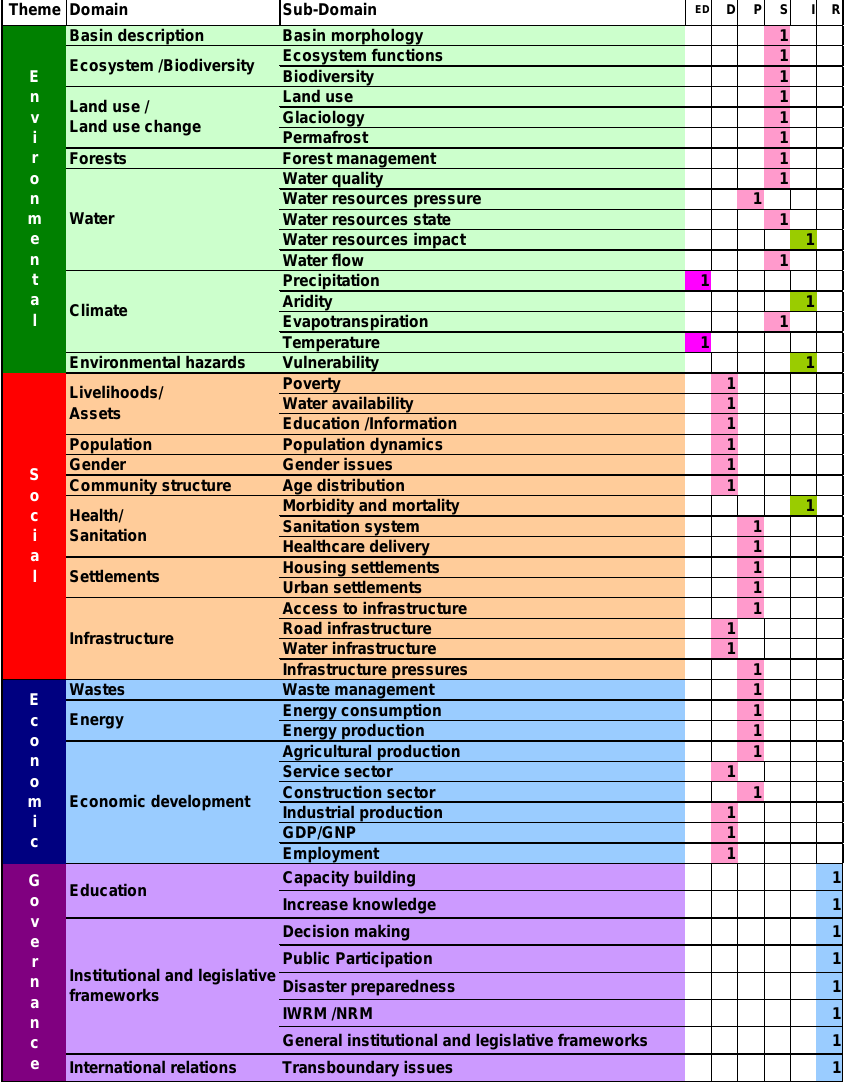
Table 6.1: Integrated Indicator Table (Themes, Domains, Sub-domains) and allocation